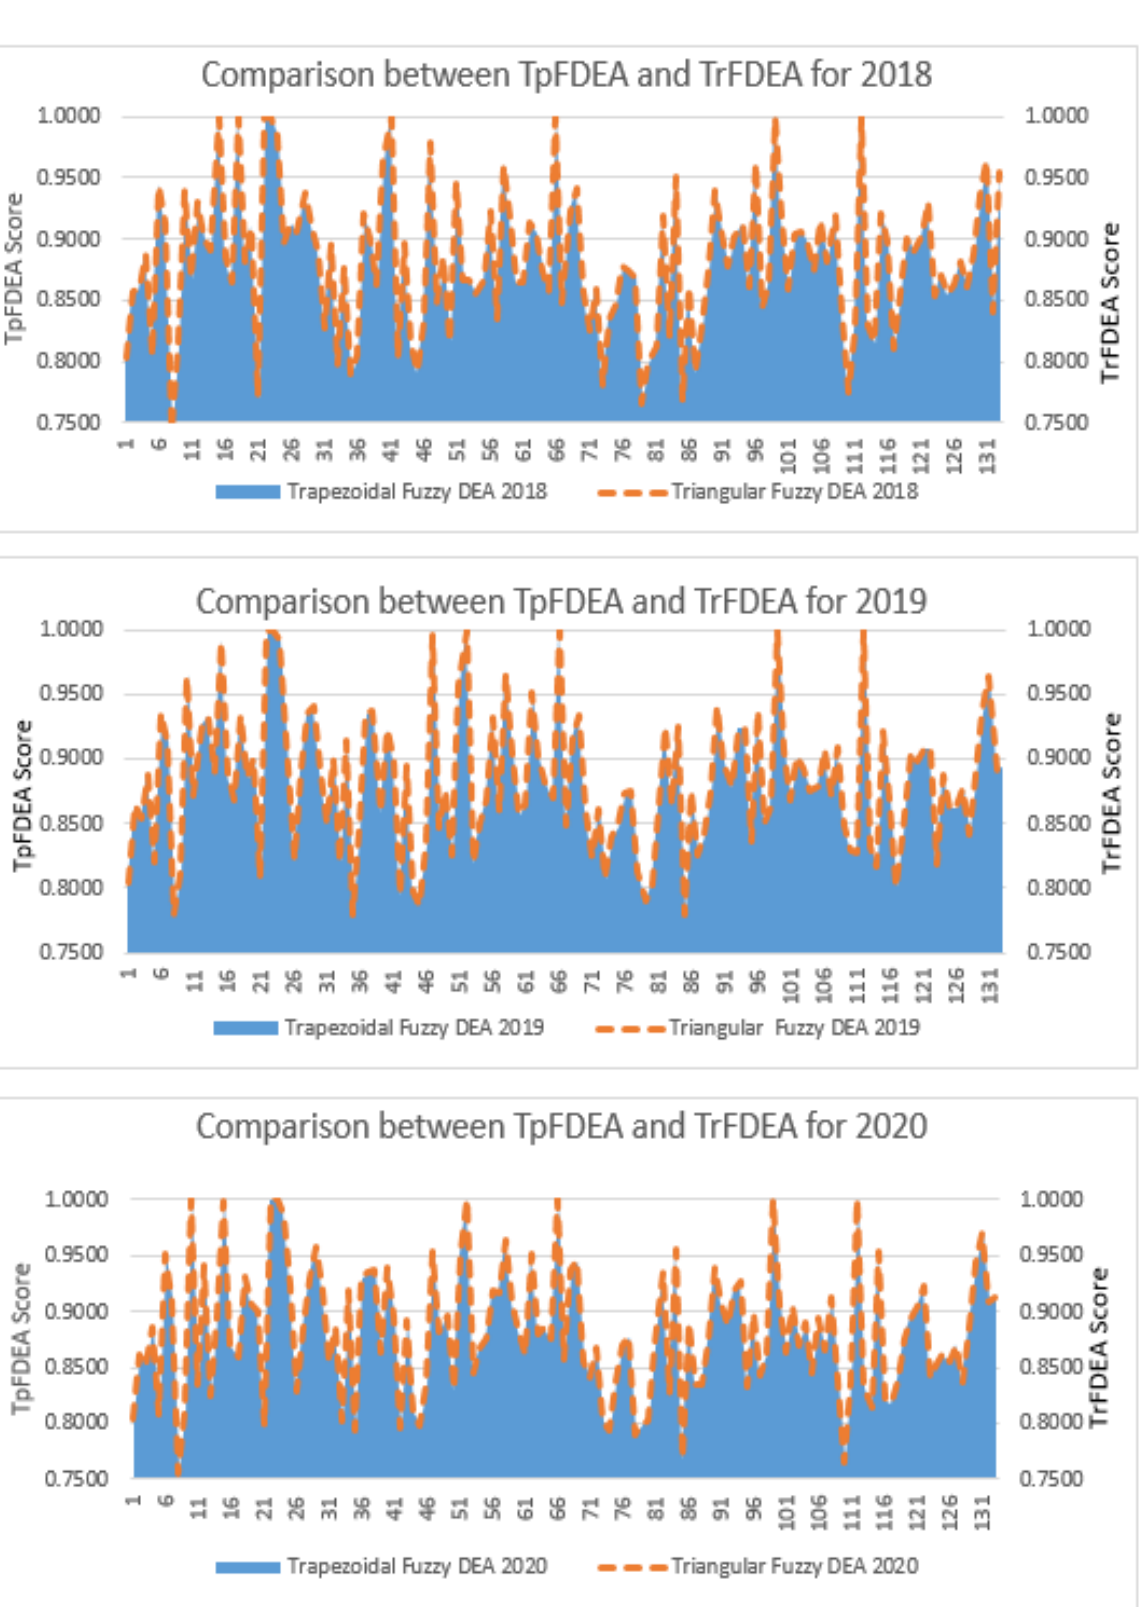
Figure 7. The differences between triangular fuzzy DEA and trapezoidal fuzzy DEA outcomes.